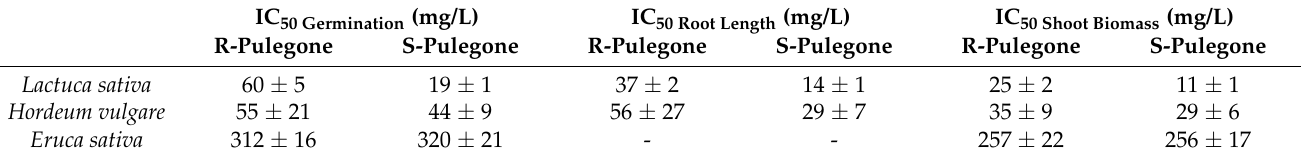
Table 2. Inhibitory concentrations (IC 50 ) of R-pulegone and S-pulegone required to reduce germina- tion, root length, and shoot biomass of Lactuca sativa , Hordeum vulgare , and Eruca sativa to 50% after 5 days of exposure in Petri